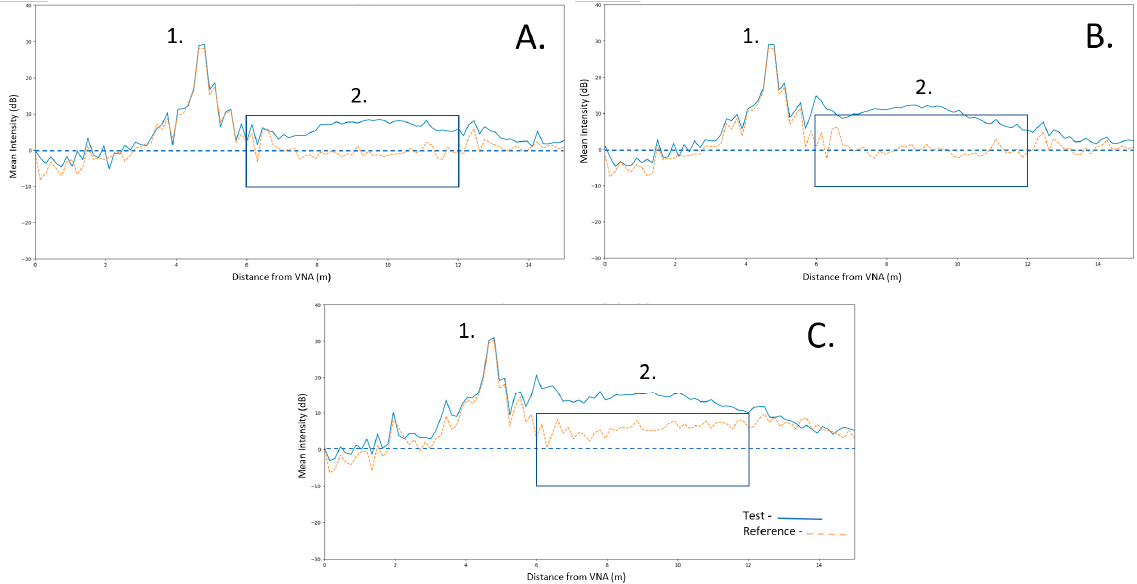
Figure 4. X-band intensity plots of irregular wave test and reference acquisitions. 1. Peak of intensity from the lip of the bridge by radar set-up. 2. ROI within wave tank (also highlighted by a blue box). Dashed line: arbitrary reference line to aid visualisation. ( A ) Nine centimetre irregular wave conditions for test and reference. Test = 40 g/m 2 of plastic bottles inside of the tank (2 bottles/m 2 ). ( B ) Nine centimetre irregular wave conditions for test and reference conditions. Test = 20 g/m 2 of plastic foam cylinders (20 cm long) inside tank. ( C ) Seventeen centimetre irregular wave conditions for test and reference conditions. Test = 10 g/m 2 of plastic lids inside tank (1.5 lids/m 2